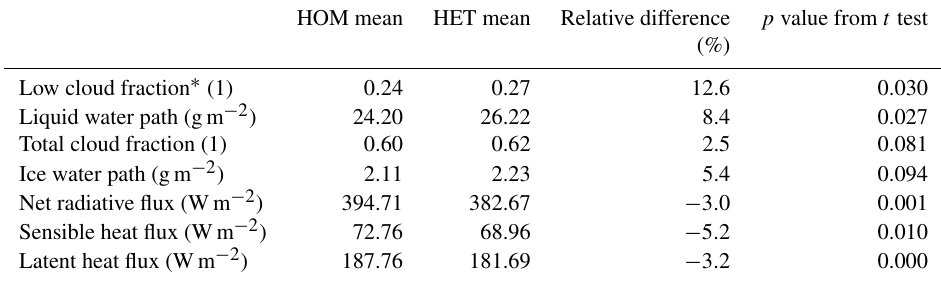
Table 3. Daytime (06:00–18:00LT) mean, relative difference, and p value from Student t test of liquid water path, ice water path, low cloud fraction, total cloud fraction, net radiation flux, sensible heat flux, and latent heat flux, over the cloudy days in HOM and HET simulations.